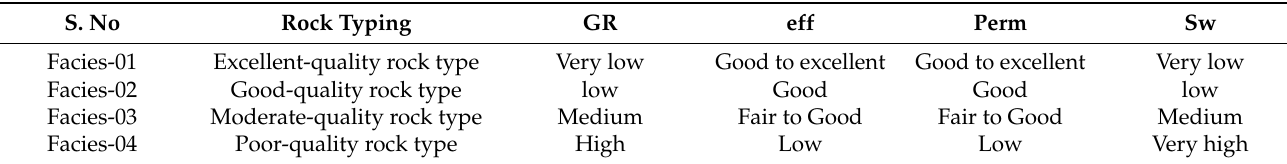
Table 2. The properties for groups of